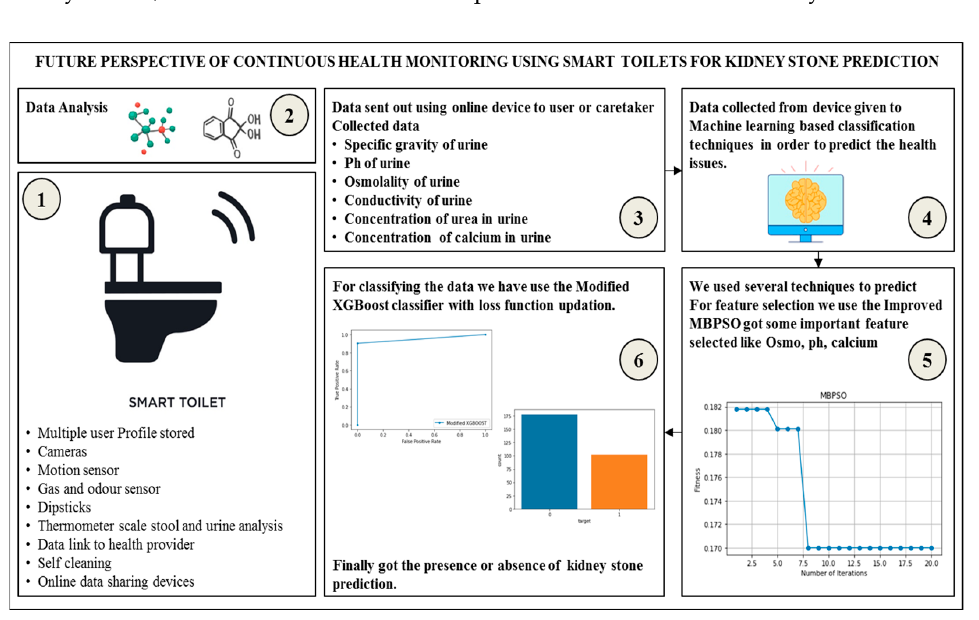
Figure 2. Illustrative diagram of the proposed model.